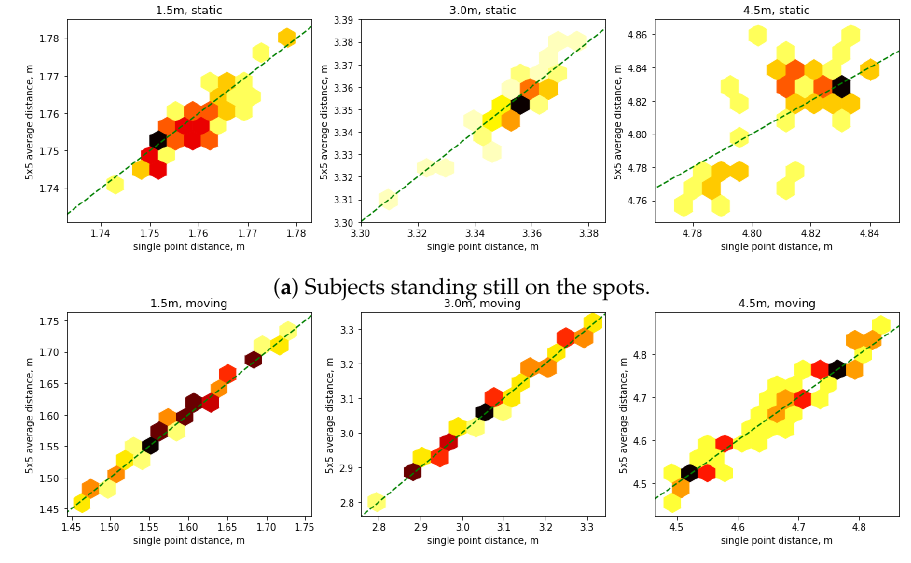
Figure 4. Scatter graphs of the depth sensor noise. Each scatter graph shows the distance measurements using single pixel depth measurement (horizontal axis), meters versus distance measurement using 5 × 5 pixels average depth measurement (vertical axis), meters. Dashed lines represent ideal linear dependency between measurements. The darker colors represent higher density of